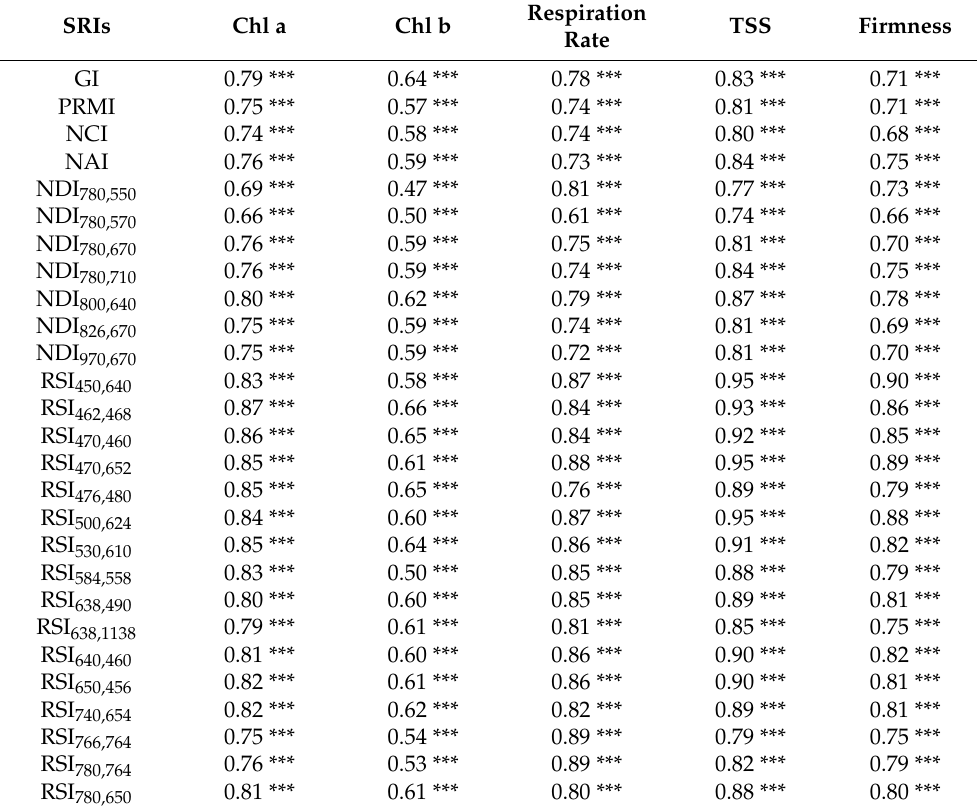
Table 5. The adjusted coefficients of determination measure the proportion of variance in Chl a, Chl b, respiration rate, TSS, and firmness that can be explained by twenty-seven SRIs of banana fruits.